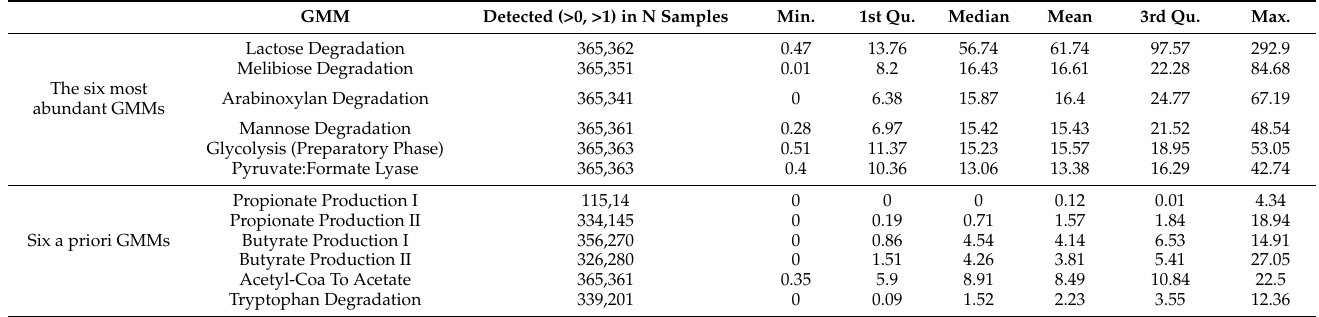
Table 2. Quantiles for the six most abundant and six a priori interesting